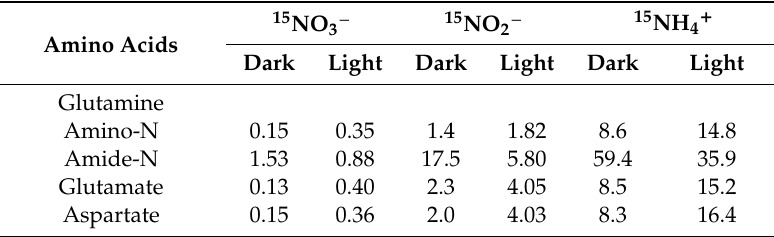
Table 1. The 15 N atom % excess of amino acids extracted from the sunflower leaf discus treated with 1 mM 15 NO 3 − , 15 NO 2 − , and 15 NH 4 + for 30 min under darkness as compared to those under the light (20,000